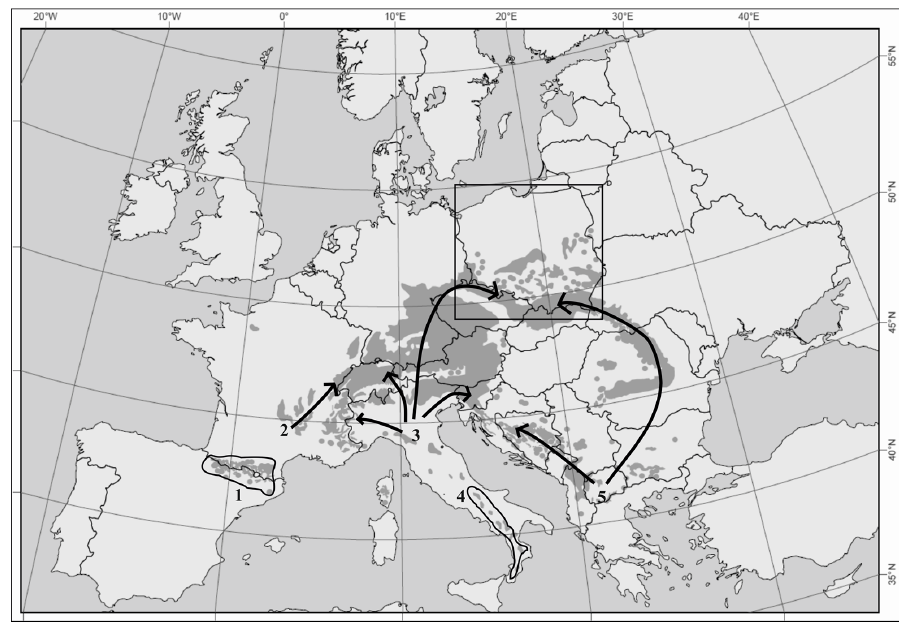
Figure 1. Map of the current natural range (grey areas), the location of glacial refugia (1—Iberian Peninsula, Pyrenees; 2—Iberian Peninsula, southwestern France; 3—Apeninne Peninsula, northwestern Italy; 4—Apennine Peninsula, southern Italy ‐ Calabria; 5—Balkan Peninsula, the southern Balkans Massif) and the most likely routes of postglacial recolonization (arrows) of Abies alba in Europe.